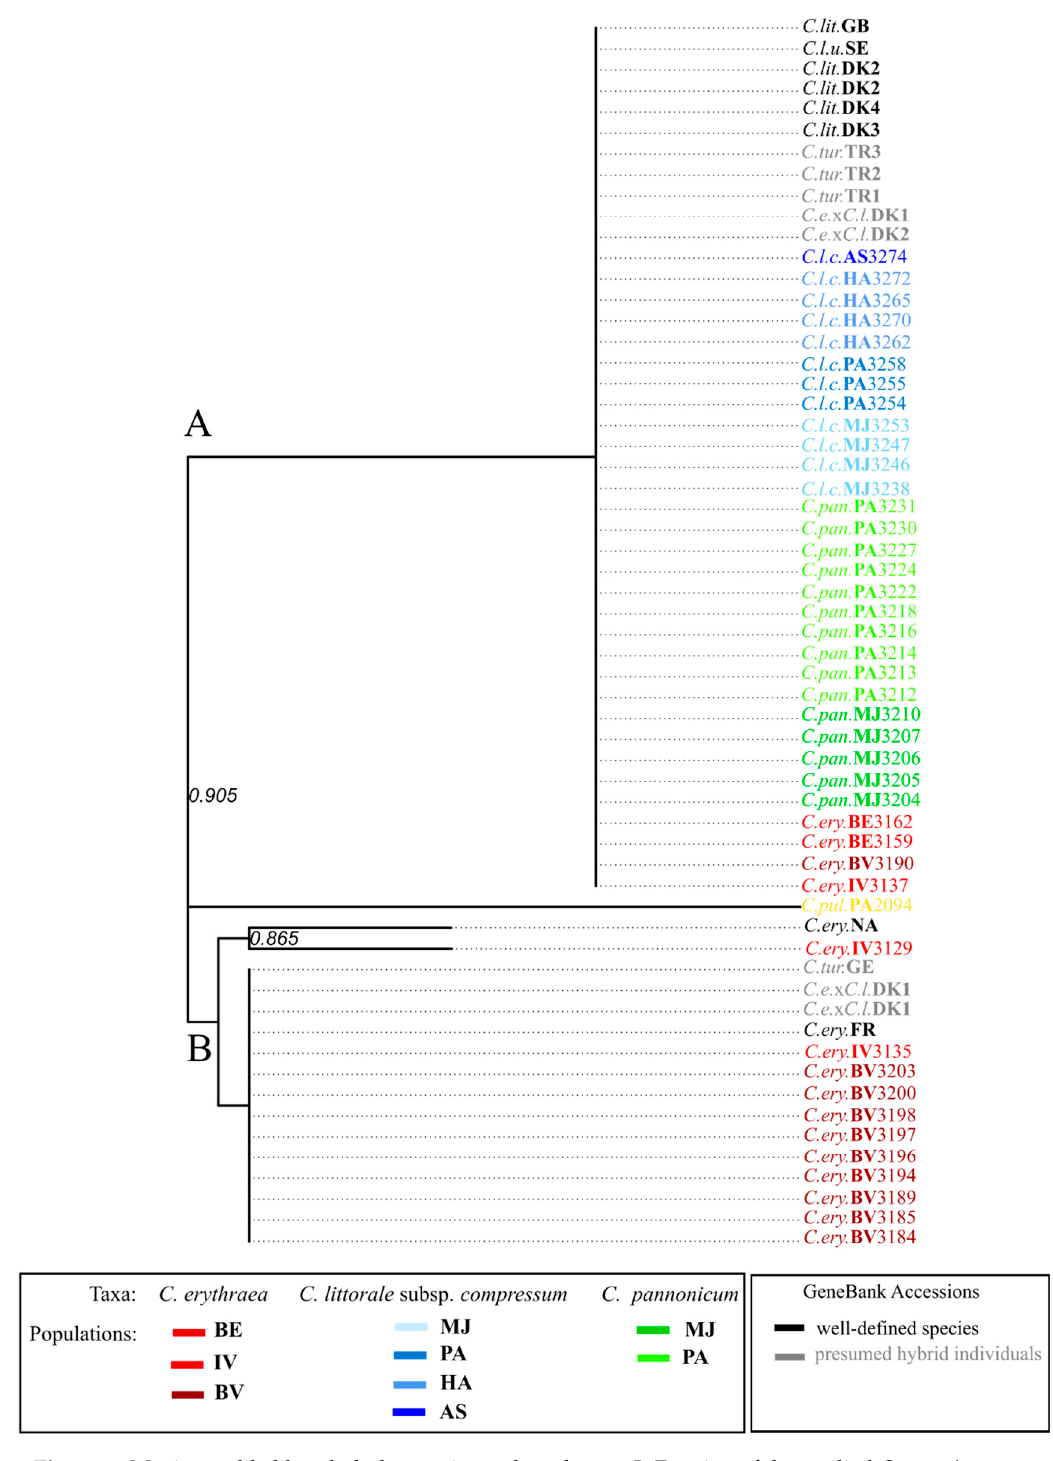
Figure 5. Maximum likelihood phylogenetic tree based on trn L-F region of the studied Centaurium taxa with C. pulchellum as outgroup. Support cluster values, estimated using the Shimodaira-Hasegawa test, are indicated. Sequence tags retrieved from the GenBank are written in black and gray letters while the initials of the country of origin are follows: GB -Great Britain, SE -Sweden, TR -Turkey, GE -Georgia, FR -France, DK -Denmark. For labels please refer to Table 3 and Table 4.